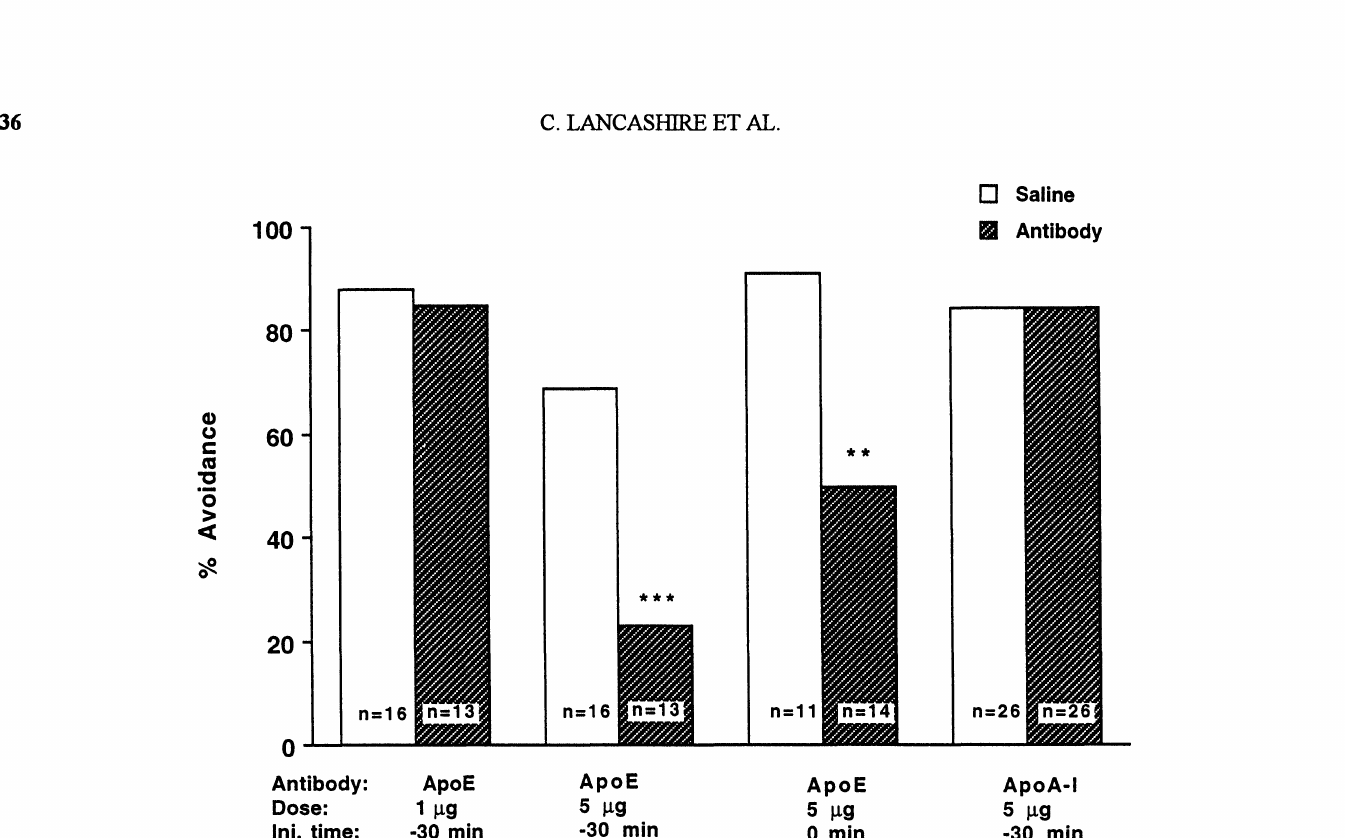
Fig. 4: The effects of anti-Apo-E and anti-ApoA-I on training retention. Chicks were trained and tested as described in the Experimental section. At 30 min pretraining or just post-training, chicks were injected bilaterally with saline or with anti- ApoE (1 or 5 Ig/hemisphere), or anti-ApoA-I (Slg/hemisphere), and then were tested for retention 24 hr post-training. The number of chicks in each group is shown in columns. Injections of 51g/hemisphere anti-ApoE, either 30 min pretraining or just post-training, resulted in amnesia when analyzed by X2 (30 min pretraining, X2